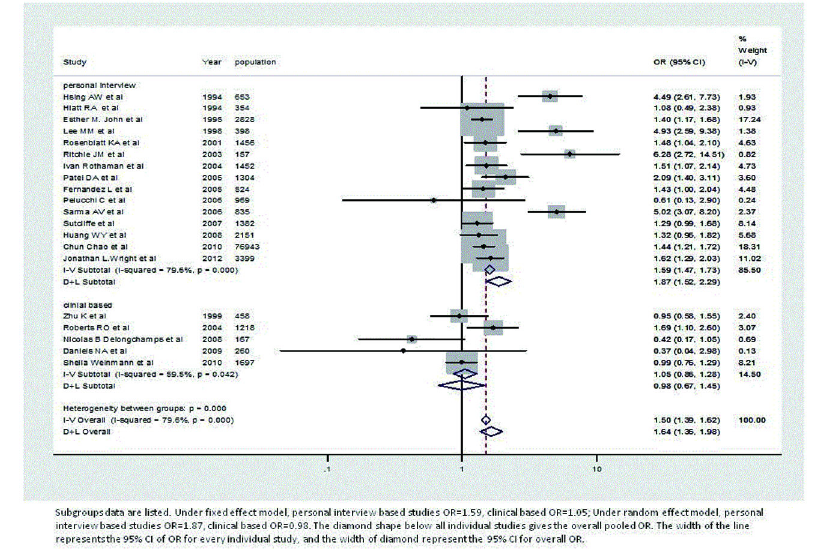
Figure 3. Forest plot of odds ratio under fixed effect and random effects model, based on data source.